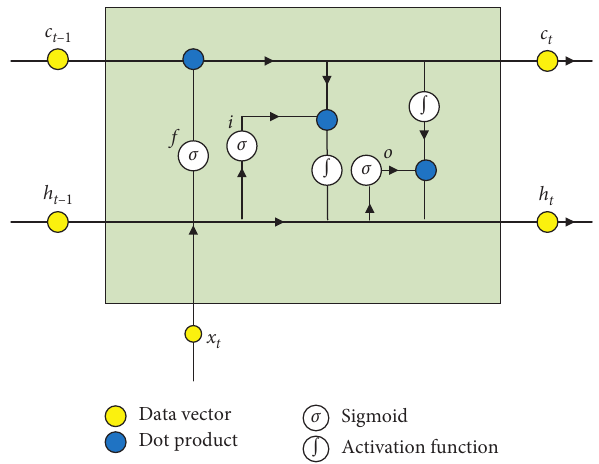
Figure 1: LSTM structure